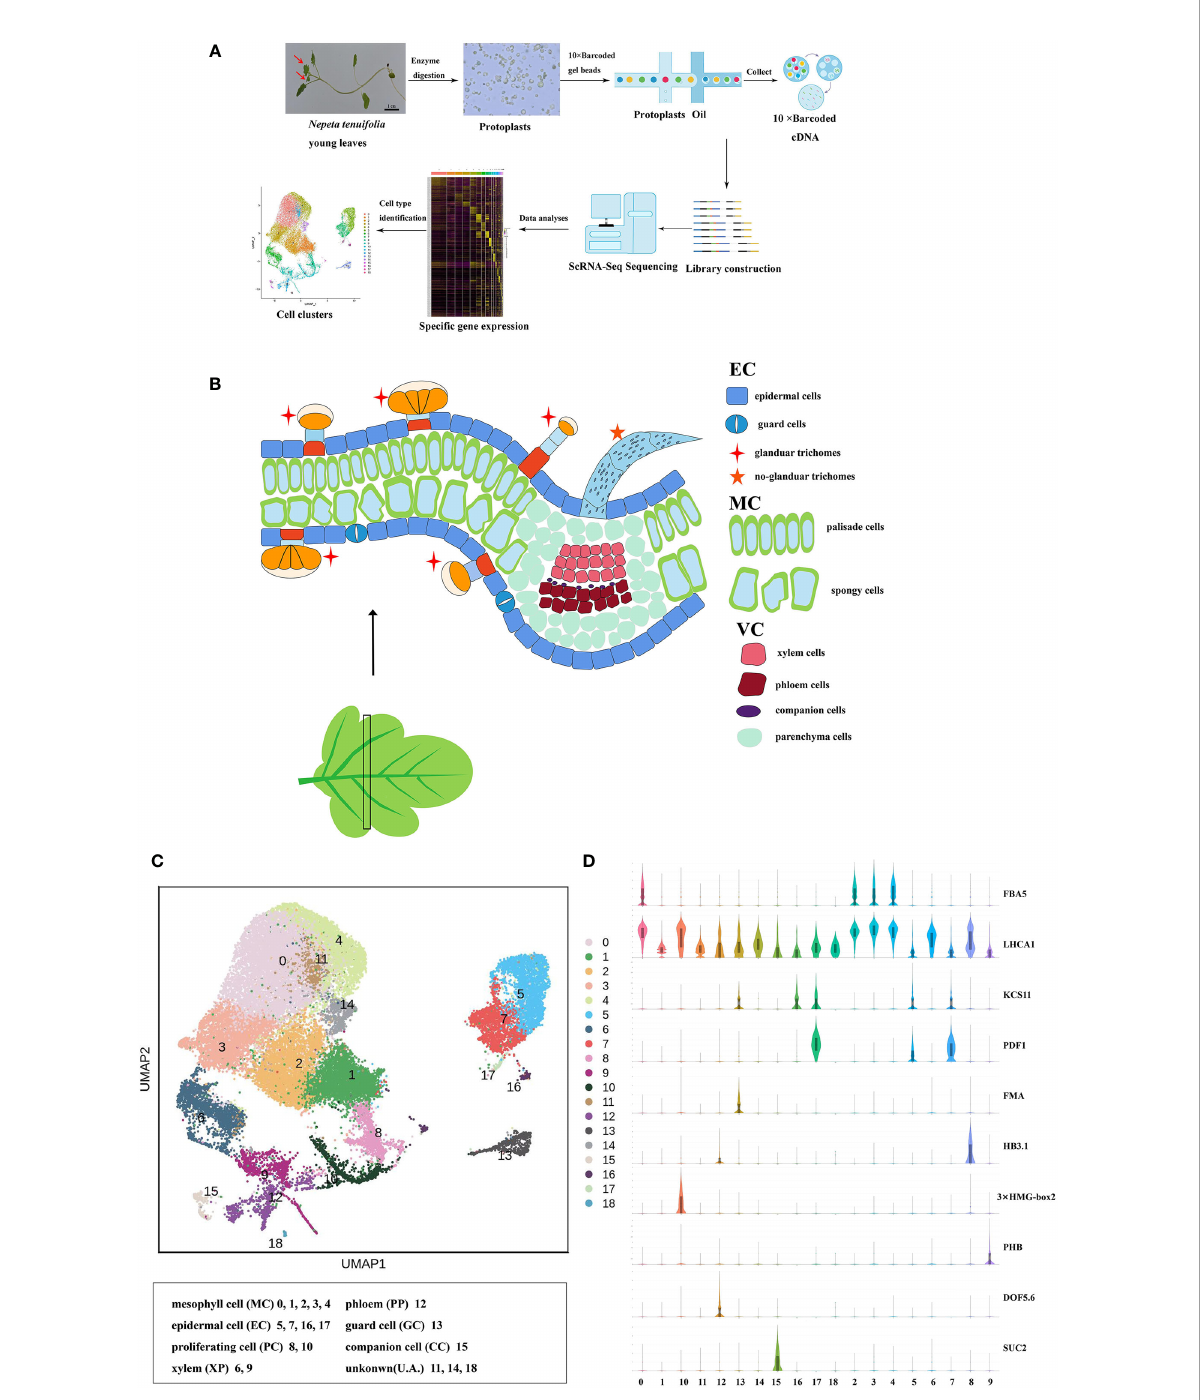
FIGURE 1 Cell heterogeneity in the N. tenuifolia young leaf. (A) Overview of N. tenuifolia young leaf scRNA-seq and cluster annotation work fl ow. (B) Schematic of anatomy and cell types of N. tenuifolia young leaf. (C) Visualization of the 19 cell clusters by UMAP. Each dot denotes a single cell. Colors denote corresponding. (D) Violin plots of known cell-type marker genes. scRNA-seq, single cell RNA sequencing; UMAP, uniform manifold approximation and